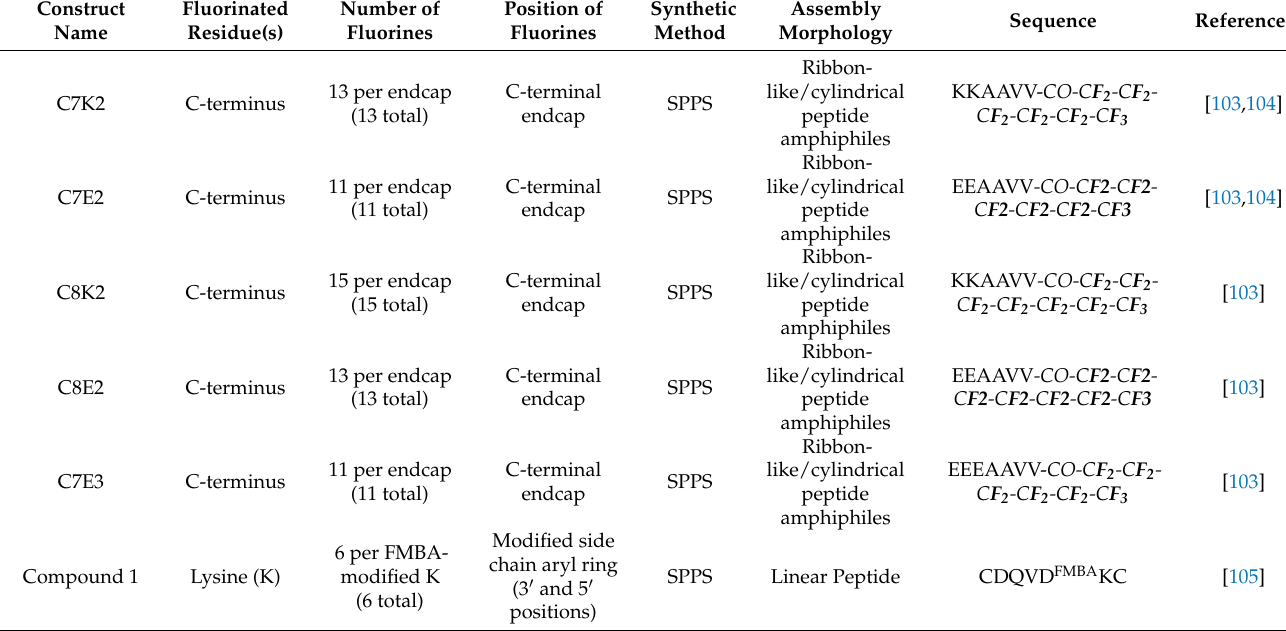
Table 5. Summary of fluorinated proteins and peptides constructs alongside their accompanying one letter AA sequences in the order they are discussed for their application as 19 F MRI